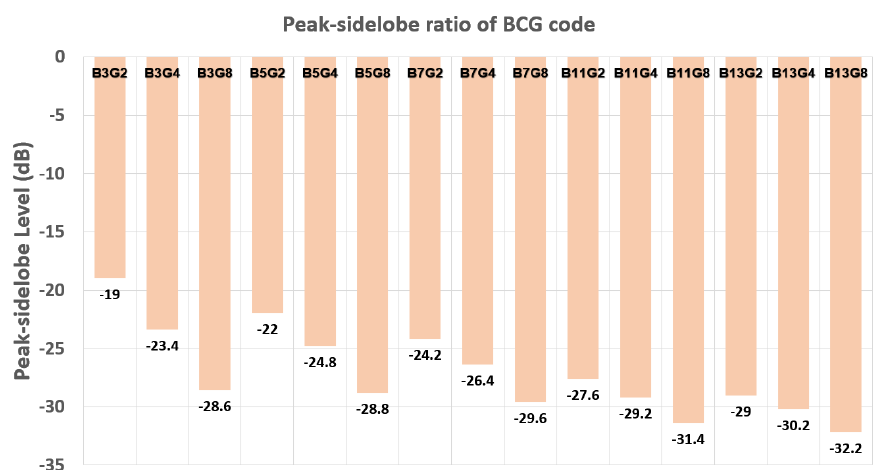
Figure 4. The peak-side lobe level of different BCG codes from numerical